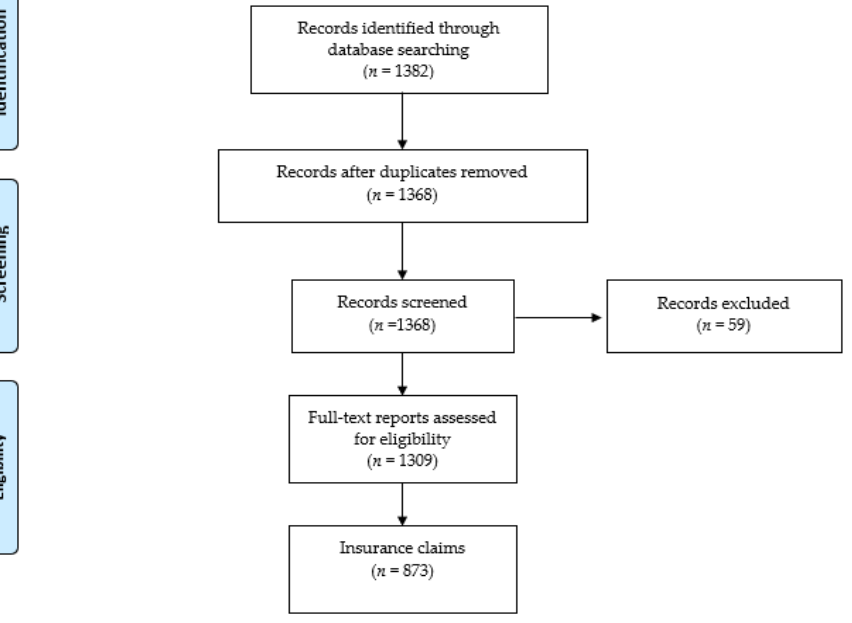
Figure 1. Flow chart of the study.